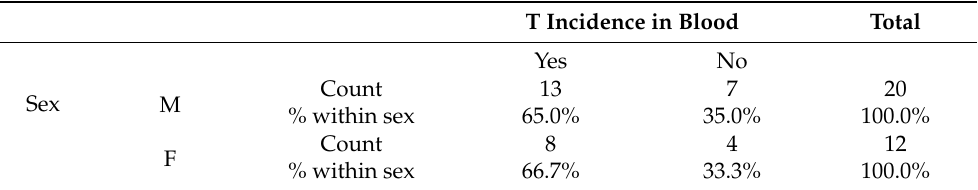
Table 8. Incidence of T in blood samples.